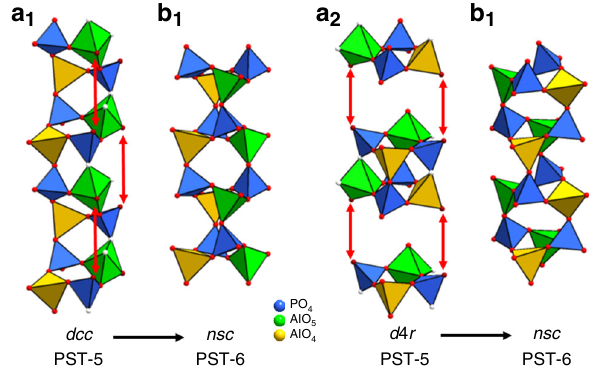
Fig. 3 Chain transformations between PST-5 and PST-6. a 1 Double- crankshaft chain ( dcc ) and a 2 double four-ring ( d 4 r ) unit in PST-5, and b 1 and b 2 narsarsukite chain ( nsc ) in PST-6. The removal of bridging hydroxyl groups associated with the dcc and d 4 r initiates the geometry changes of penta-coordinated Al atoms, resulting in cleavage of Al – O – P bonds (corresponding O atoms are shown in white) followed by inversion and reconnection of the tetrahedra (indicated by arrows). Both dcc and d 4 r transform to nsc in PST-6. Green, penta-coordinated (and penta- coordinated derived) AlO 4 tetrahedra; yellow, tetra-coordinated AlO 4 ; blue, PO 4 . Oxygen atoms associated with OH or bond-breaking in the chains are shown in white and the rest O in (Fig. 2a 2 , b 2 ) and thereby different pore systems; 1D for PST-6, in contrast to 2D for PST-5.